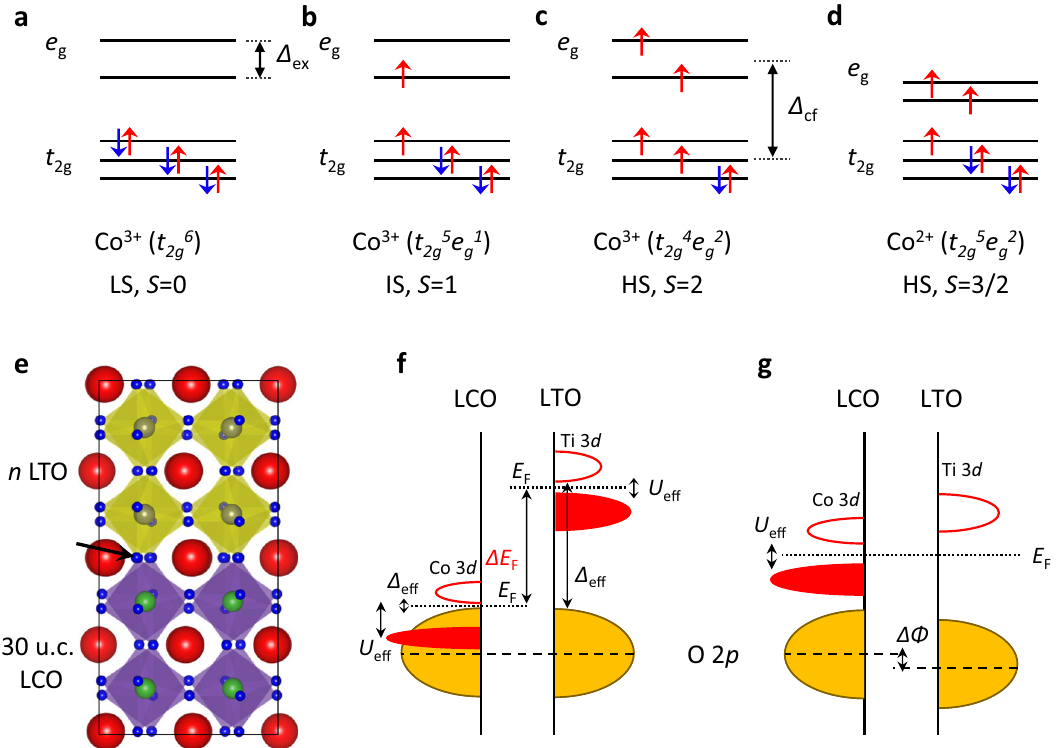
Fig. 1 Spin states of Co ions and electronic band structure of LCO/LTO. a – d Spin states of Co ions. Δ cf , crystal fi eld splitting, Δ ex , intra-atomic exchange energy. e Schematic diagram of 30u.c.-LaCoO 3 (LCO)/ n -LaTiO 3 (LTO) heterostructure grown on SrTiO 3 (STO) substrate. We refer to this heterostructure as C30/T n . The black arrow indicates the shared oxygen sites at the interface. f Electronic band structures of LCO and LTO. E F , Fermi level; Δ eff , charge- transfer gap; U eff , Mott – Hubbard gap. g The fi nal equilibrium state wherein the Δ E F can be removed by charge transfer from Ti to Co. ΔΦ , electrostatic potential